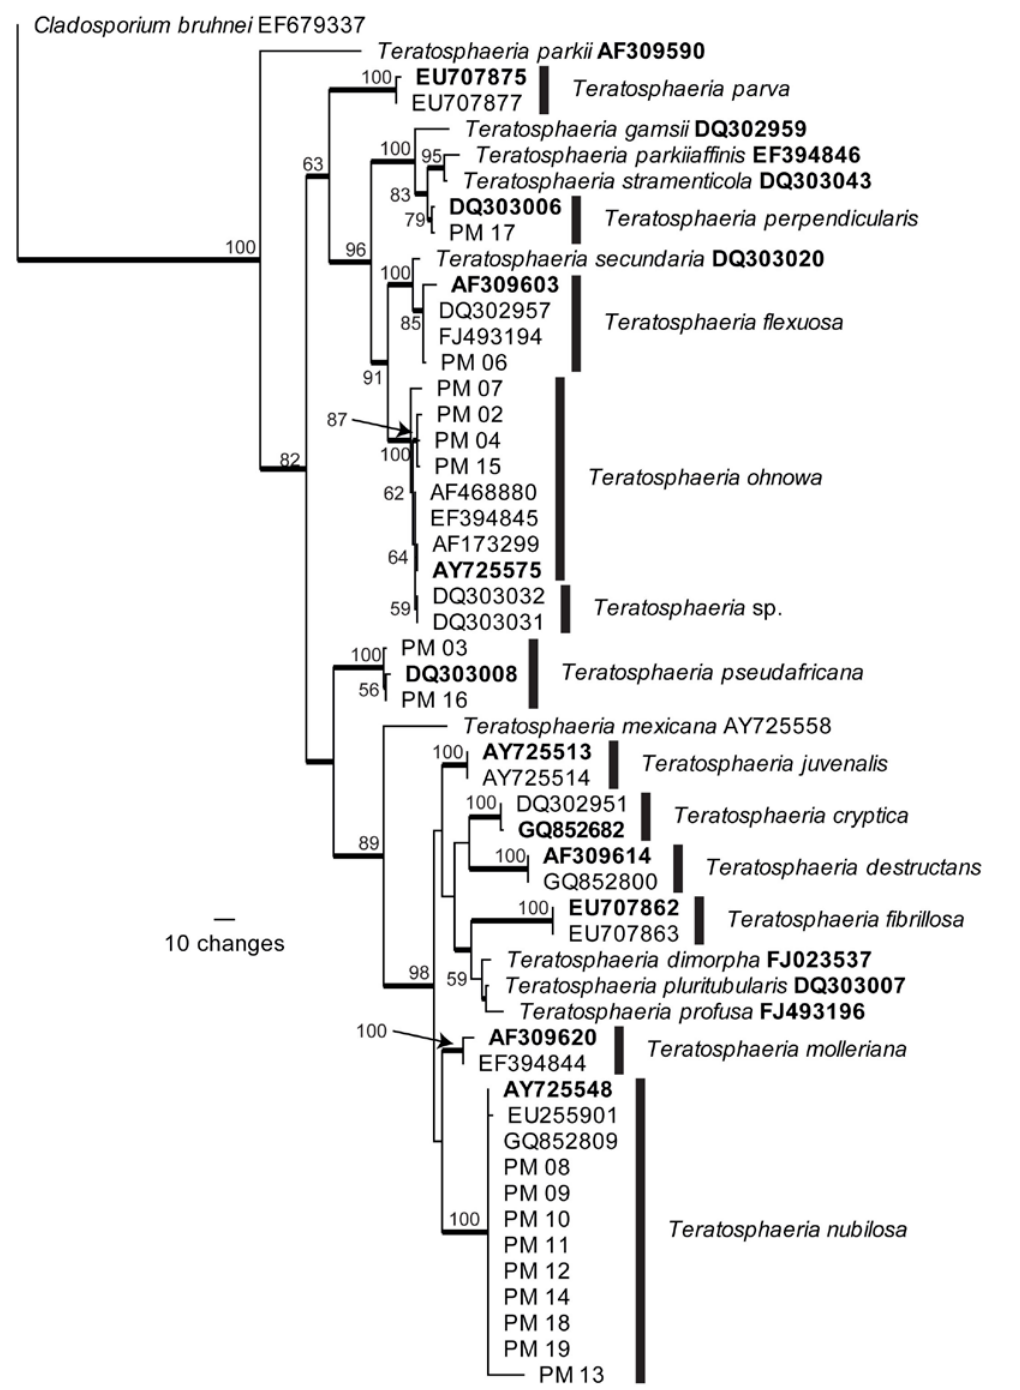
Figure 2. The first of 15 equally most parsimonious trees obtained from a heuristic search with 100 random taxon additions of the Teratosphaeria ITS sequence alignment. The scale bar shows ten changes, and bootstrap support values from 1000 replicates are shown at the nodes. The sequences from ex-type strains are shown in bold face and branches present in the strict consensus tree are thickened. The tree was rooted to Cladosporium bruhnei (GenBank